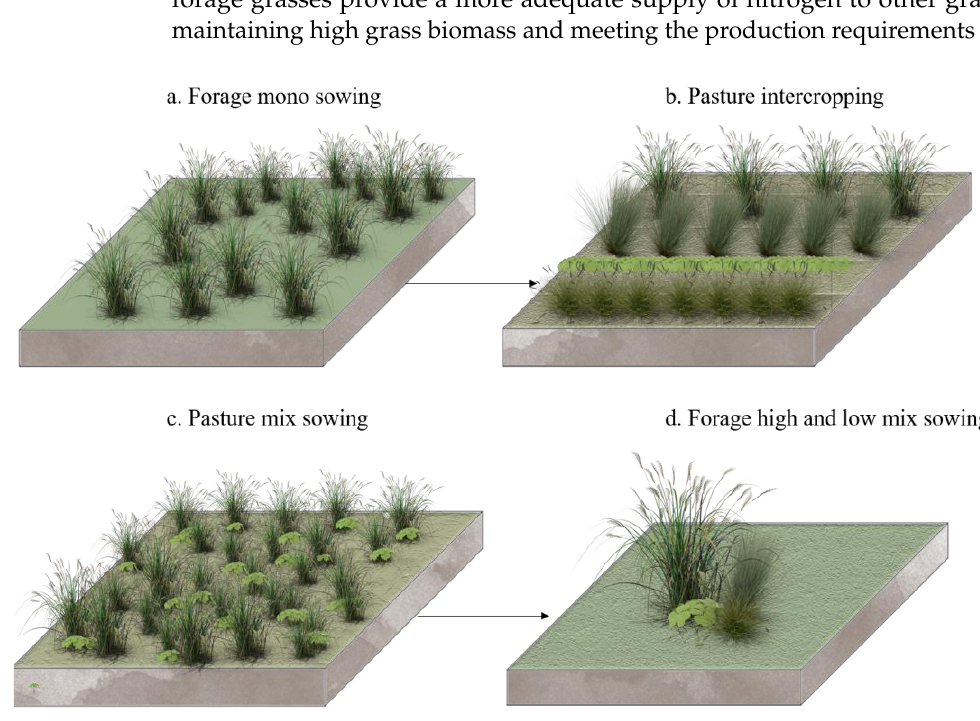
Figure 3. Artificial grassland planting structure. ( a ) Forage mono sowing: Grass forage, Lolium perenne L., ( b ) Pasture intercropping: Grasses-Leguminosae Forage, Lolium perenne L. + Medicago sativa L., Trifolium repens L.+ Lolium perenne L., ( c ) Pasture mix sowing: Grasses-Leguminosae Forage, Lolium perenne L. + Medicago sativa L., ( d ) Forage high and low mix sowing: Lolium perenne L. + Medicago sativa L. + Trifolium repens L. + Lolium perenne L. (The grass species of ( b – d ) are the same, but the arrangement of planting order is different. ( b , c ) are planted in a horizontal way, but the density and proportion of planting are different. ( b ) is good for personnel to manage, and ( c ) is good for the nutrient complementation of grass species. ( d ) is planted in a vertical way, which can fully utilize light, heat, water and air).